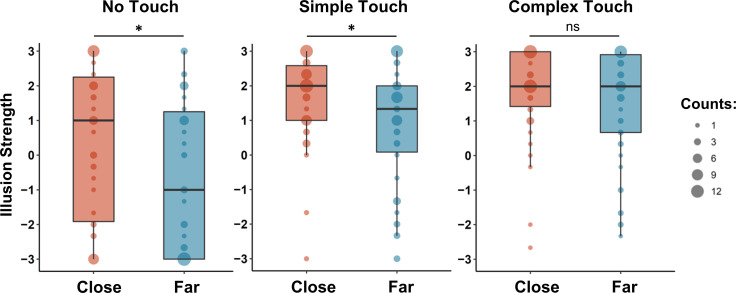
Changes in the effect of distance between hands on RHI strength due to the amount of tactile information present during RHI elicitation.The boxplots depict medians of subjective RHI strength (bold horizontal lines), upper values of the first and third quartiles (lower and upper sides of the box), and interquartile ranges for different elicitation conditions. The illusion was attenuated at the farther distance only in the conditions of absent or simplified tactile stimulation; no significant differences were observed for complex stimulation patterns. * p < 0.05.